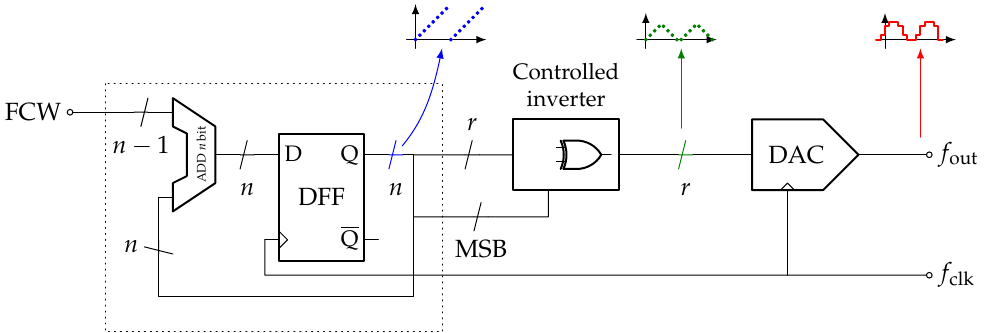
Figure 13. RF-DDFS with a nonlinear DAC (NL-DAC).